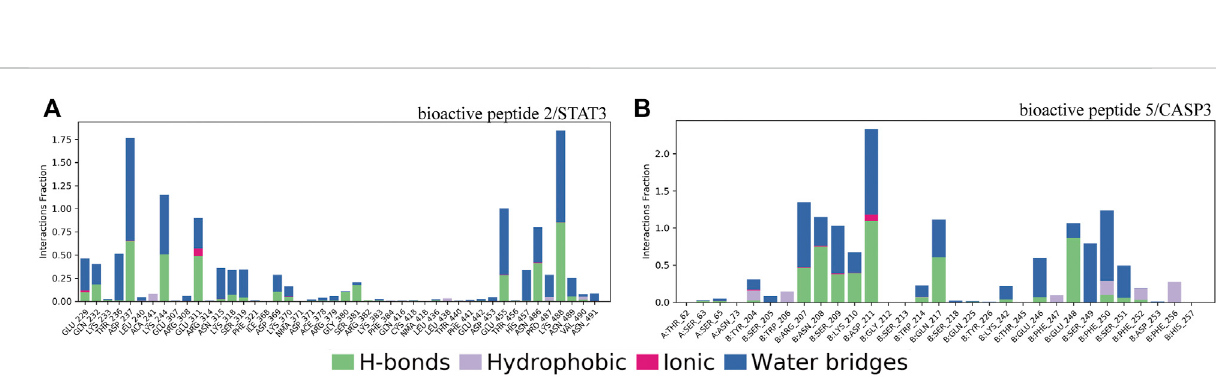
FIGURE 11 Interaction of proteins and ligands during molecule dynamics. (A) bioactive peptide 2/STAT3; (B) bioactive peptide 5/CASP3. The stacked bar charts are normalized over the course of the trajectory: for example, a value of .7 suggests that 70% of the simulation time the speci fi c interaction is